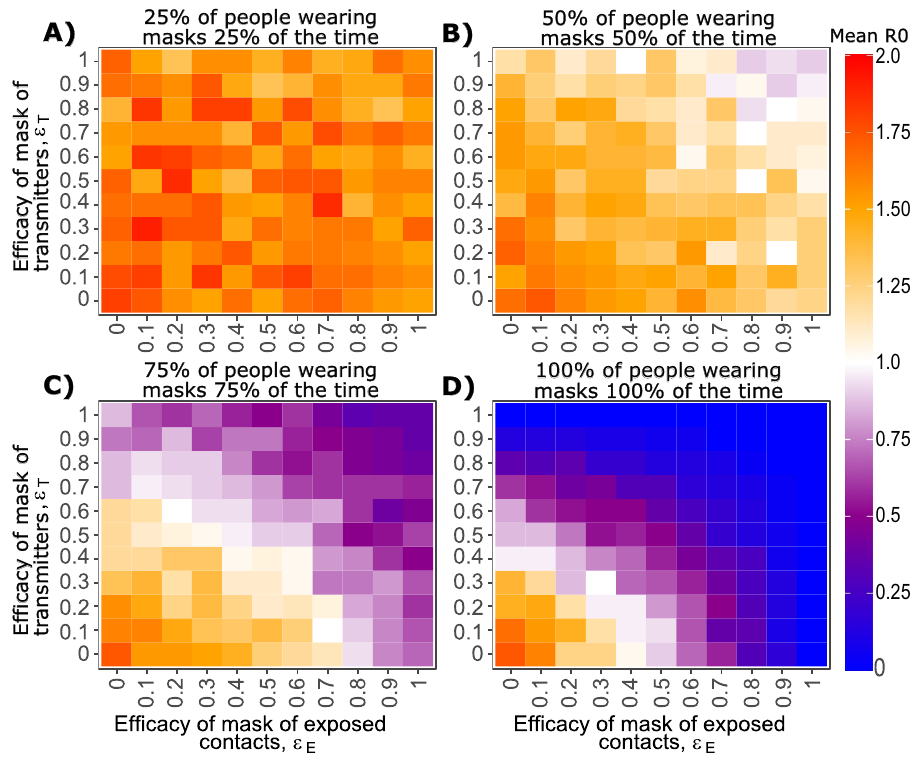
Figure 3. Effect of mask utilization and efficacy on mean SARS-CoV-2 effective reproductive number. Heat maps (color denotes basic reproductive number) with varying efficacy for both exposed and transmitters. Each panel includes simulations of 3000 transmitters with varying daily exposure contacts and ( A ) low ( B ) moderate ( C ) high, and ( D ) perfect mask usage. Specifics of mask use are noted in panel